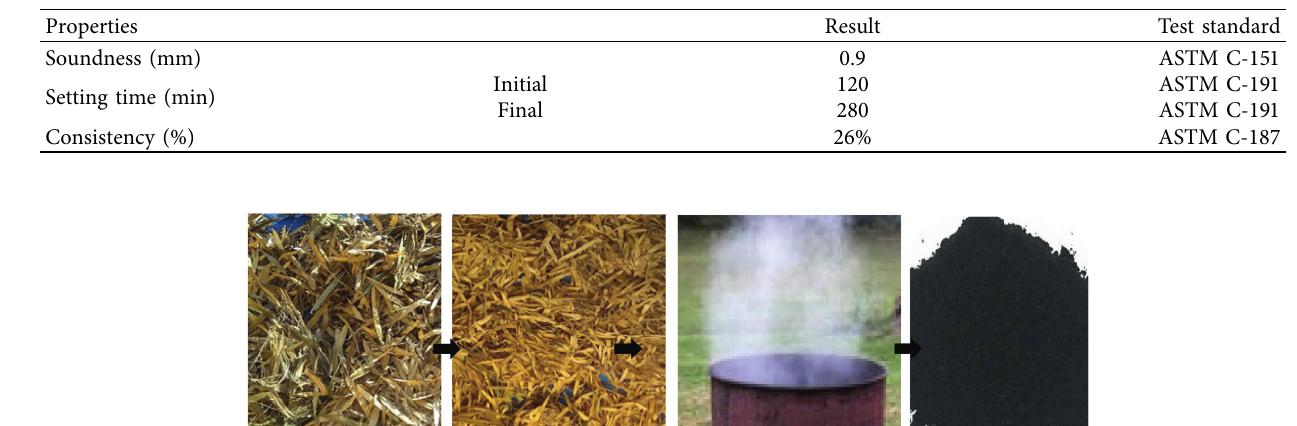
Table 1: Cement properties.